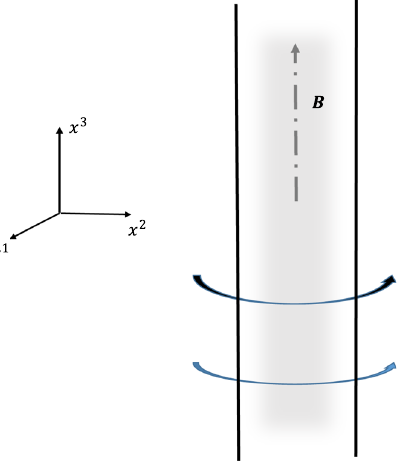
Fig. 2 Vortex.Thehelicoidalsurface χ thatrepresentsthevortextopo- logical singularity. The axis of the vortex is the line of singularity occu- pied by the normal electrons. The current j , flows around the singularity